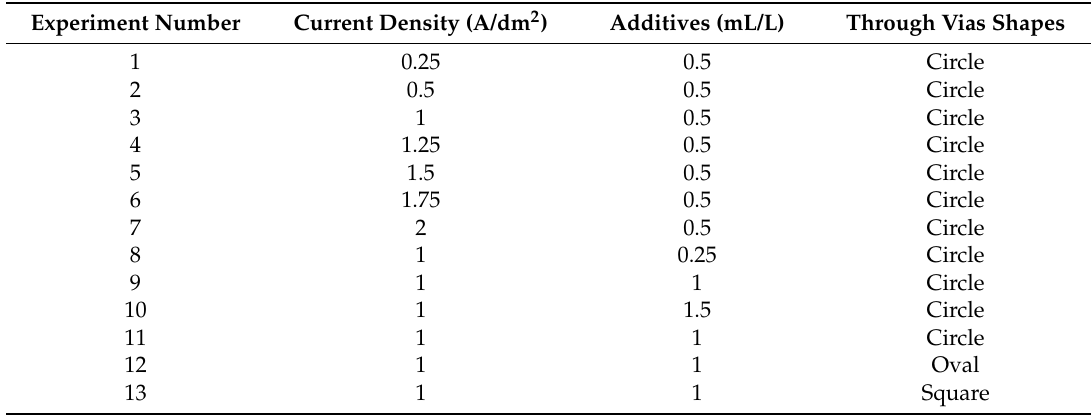
Table 2. Control variable experimental parameters.